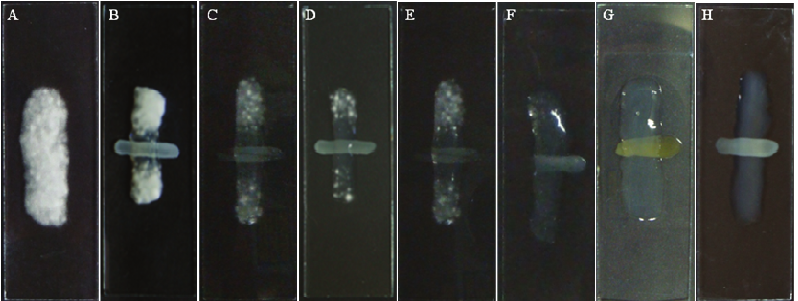
Figure 3. Antifungal activity of nail lacquer with different concentrations of extract against T. rubrum . A= Control; B= Nail lacquer without fraction; Nail lacquer with fraction: C=2.5 mg/mL; D= 5 mg/mL; E= 10 mg/mL; F= 20 mg/mL; G= 40 mg/mL; H=